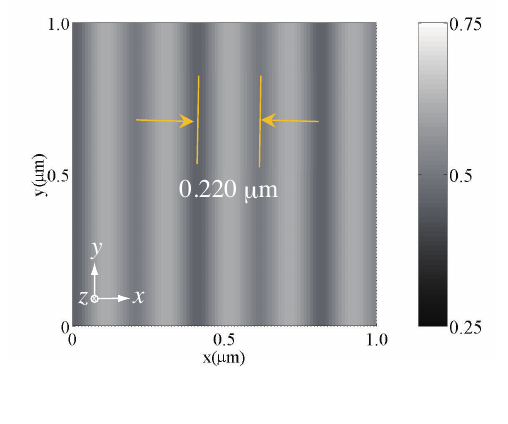
Figure 9. Calculated cross section of the polymer concentration distribution in the x - y plane at z = 0.078 µ m prepared by p-polarized three-beam interference holographic